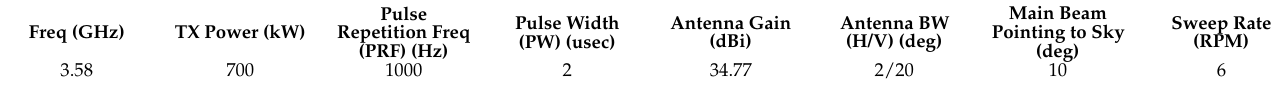
Figure 10. ( a ) TAR antenna phase center location, ( b ) the top view, and ( c ) a 3D view of TAR antenna radiation pattern. Table 4. Parameters of TAR.